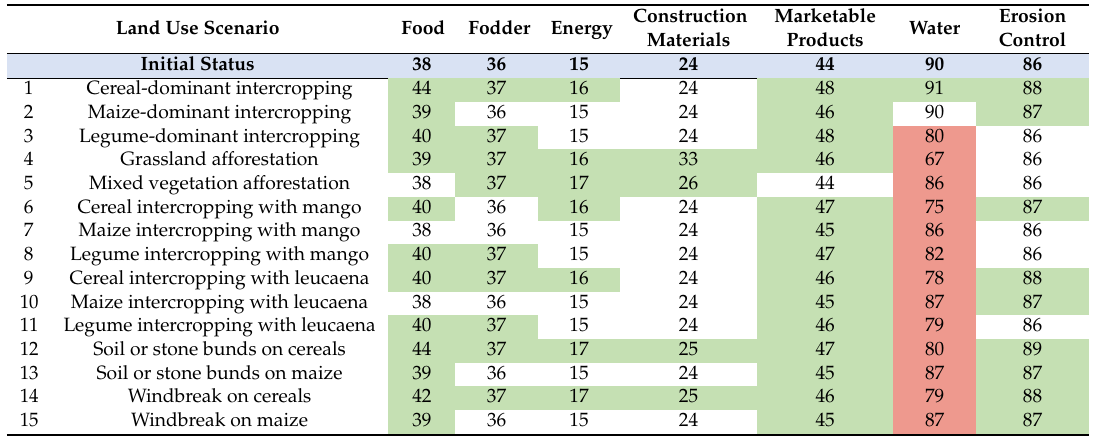
Table 7. The fifteen land use scenarios and their potential changes in ecosystem services provision for Bongo. The increase from the initial (current) status is expressed by green color, while the decrease is displayed by red color. White means no change in the provision of ecosystem services compared to current land